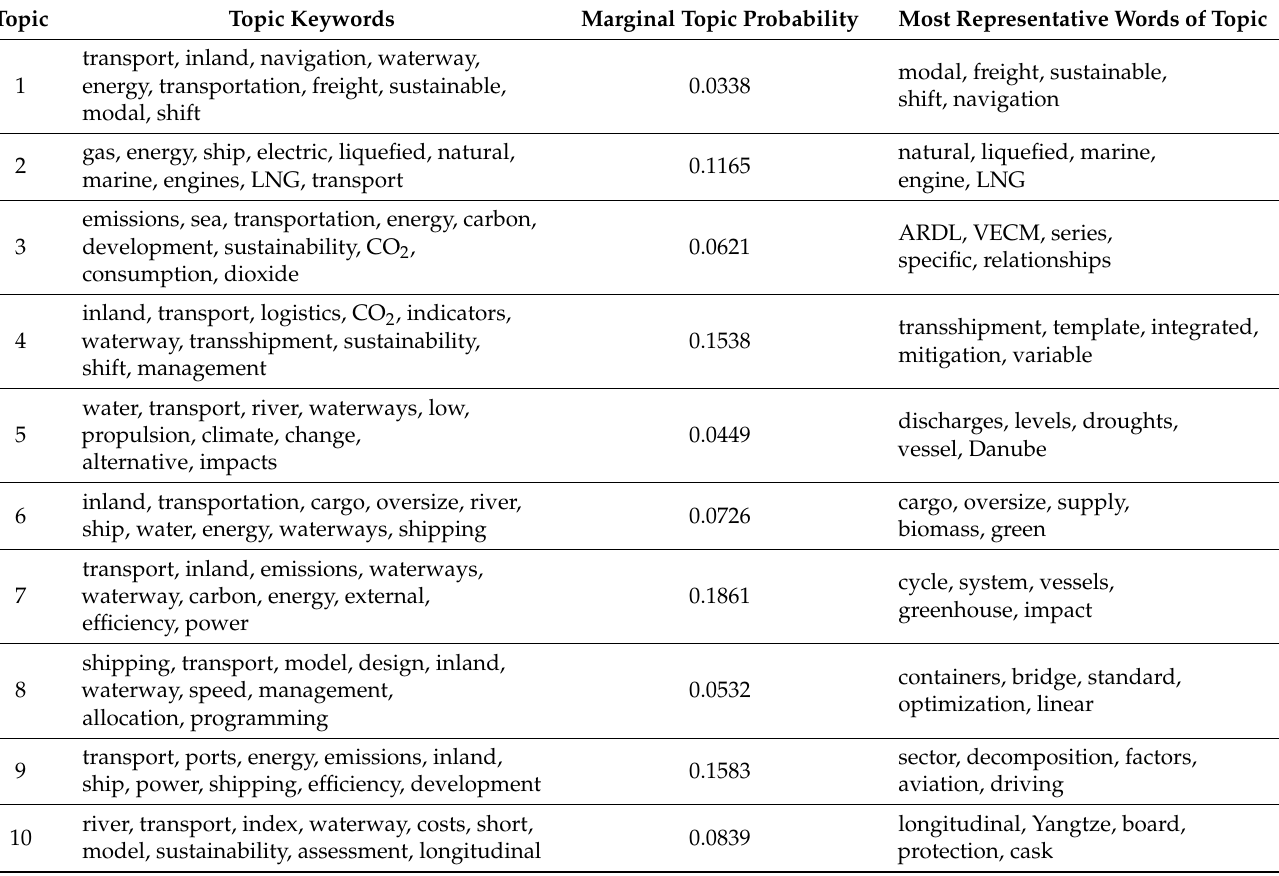
Table 1. Topic modeling using the Latent Dirichlet Allocation technique and MDS.